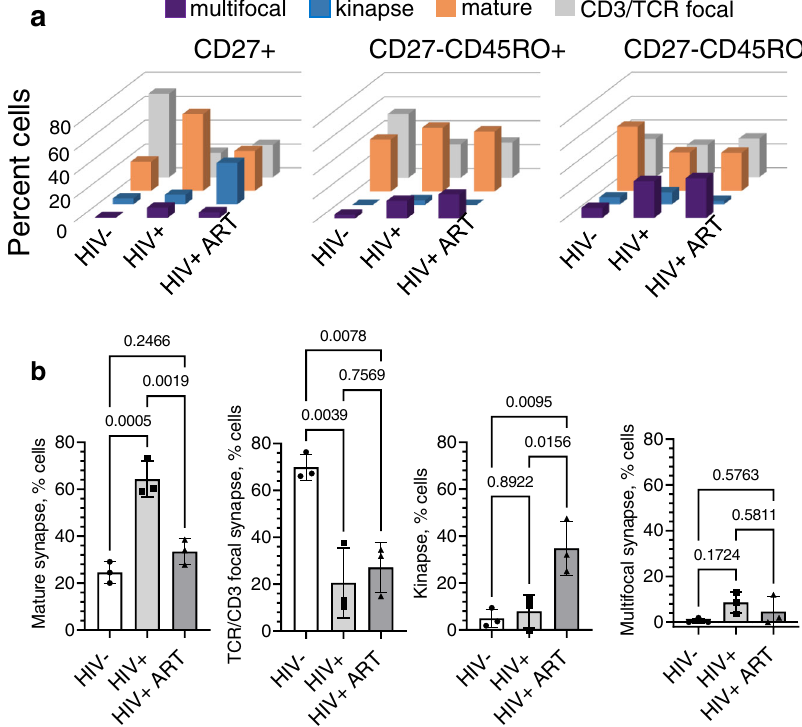
Fig.4|Dissimilarityofthesynapticinterfacesestablishedbypolyclonalhuman CD8 T cells from HIV-, chronic HIV+ and ART-treated HIV+ individuals is most pronounce at early stage of differentiation. CD27+, CD27-CD45RO+ and CD27- CD45RO − subsets of CD8 T cells from HIV-, chronic HIV+ and ART-treated HIV+ individuals were isolated by magnetic sorting and loaded on bilayers containing anti-CD3antibodiesandICAM-1.Theformationofsynapticinterfaceswasobserved for 30min by confocal microscopy. a 3D plots represent frequency of CD27+, CD27-CD45RO+, and CD27-CD45RO − CD8 T subsets that form mature synapses, TCR/D3 focal interfaces, multifocal synapses and kinapses at a T cell-bilayer